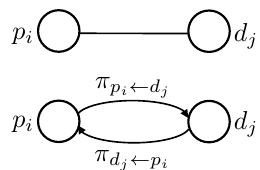
Figure 3. Example of a pairwise relationship between a vertex of type p and other one of type d .